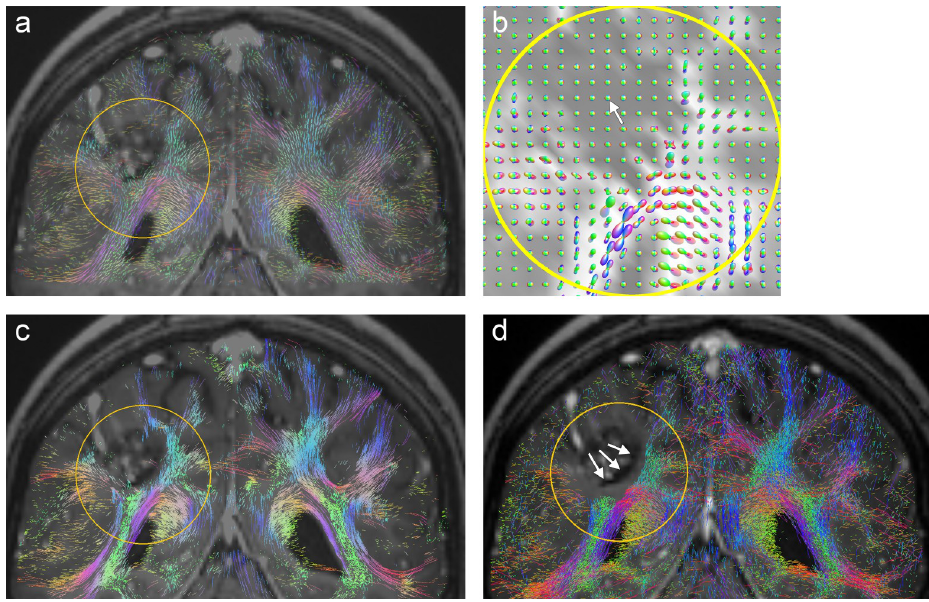
Fig 4. Visualization results from patient B: (a) Coronal A-Glyph LIC slice with ROI (yellow), (b) ODF glyphs, (c) corresponding slices from tractography results, (c) deterministic, and (d) probabilistic. Arrows in (d) indicate unrealistic fiber disruptions in the vicinity of the